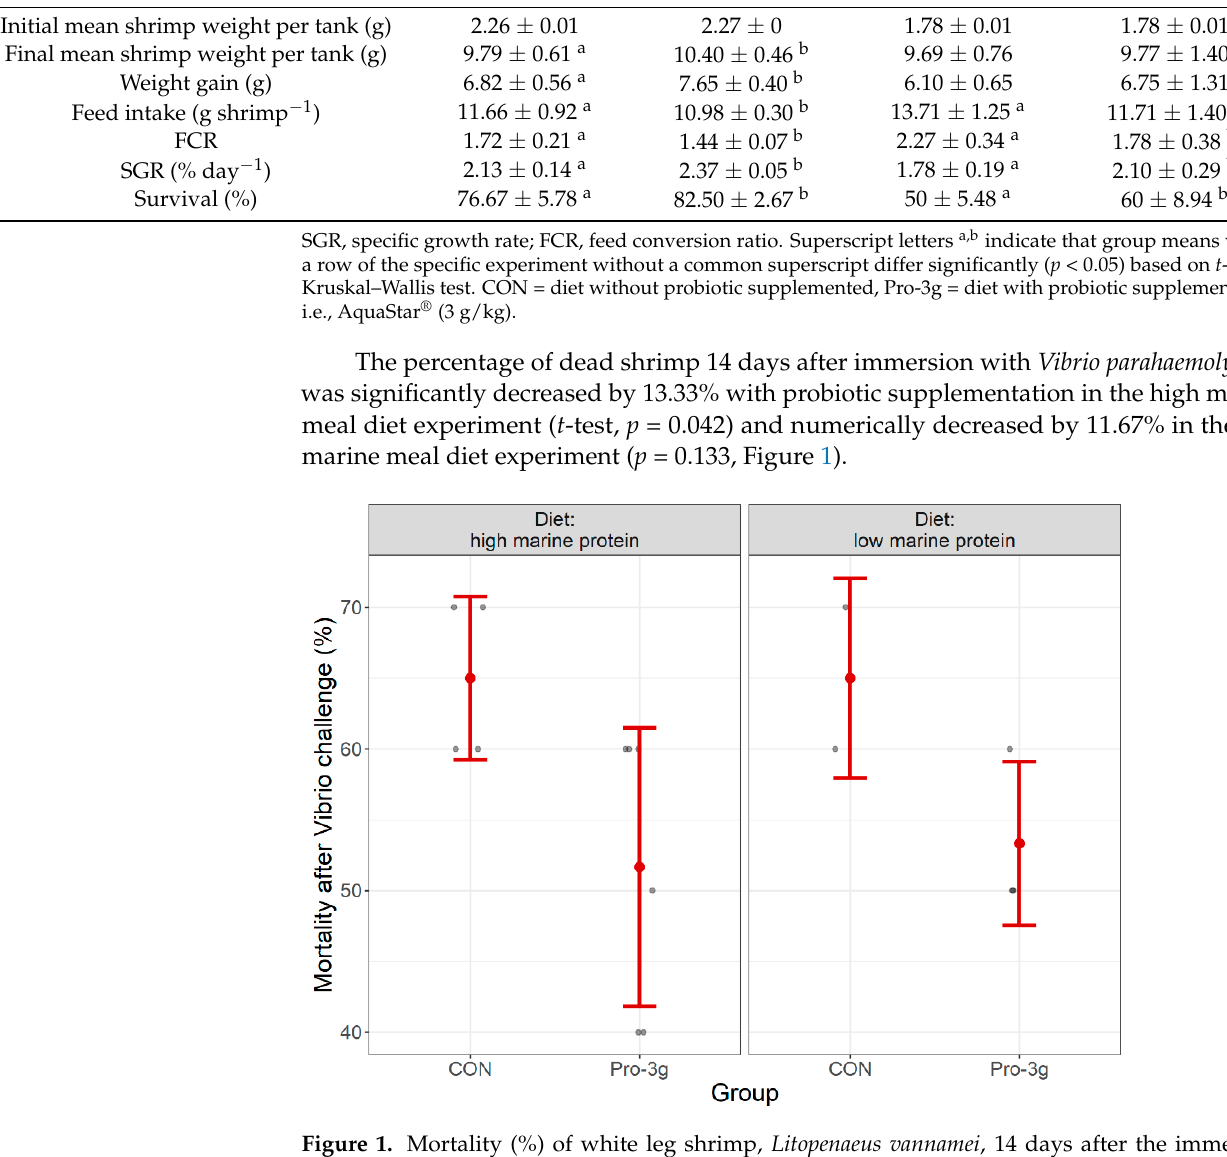
Figure 1. Mortality (%) of white leg shrimp, Litopenaeus vannamei , 14 days after the immersion challenge with Vibrio parahaemolyticus . The group mean is represented by the red dot and standard deviation is indicated using the red whiskers. The dark dots are the mortality of the specific replicates per group. CON = diet without probiotic supplemented, Pro-3g = diet with probiotic supplementation, i.e., AquaStar ® (3 g/kg).